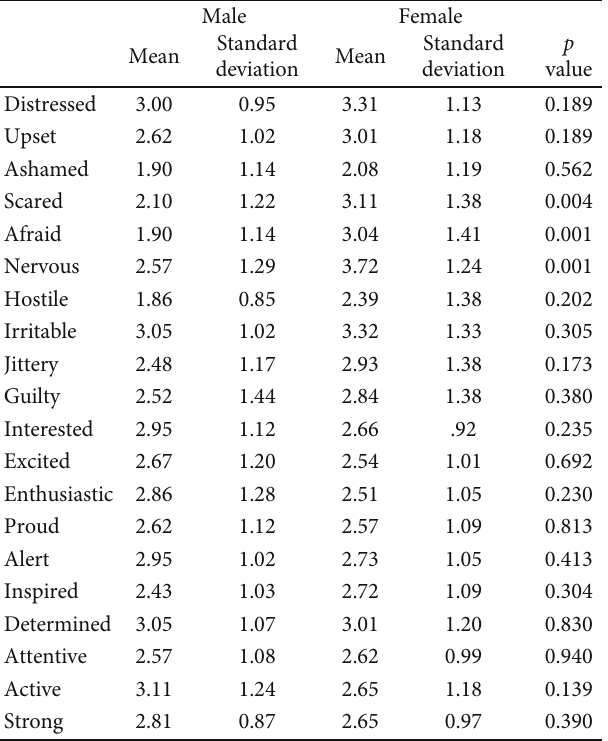
Table 6: Mean, standard deviation of positive and negative emotions by